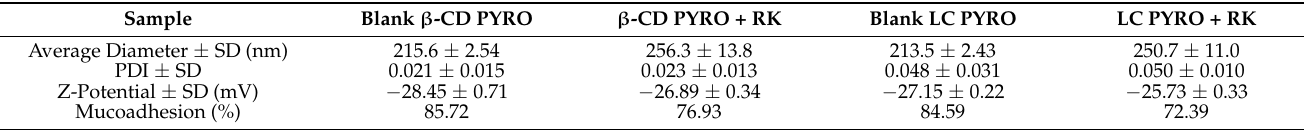
Table 1. Physicochemical characterization of blank and RK-loaded NSs.